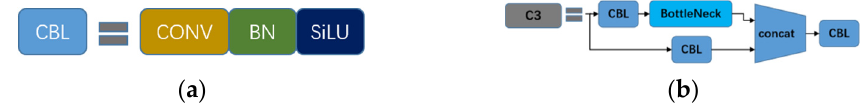
Figure 4. The CBL module and C3 module. ( a ) CBL module, ( b ) C3 module.